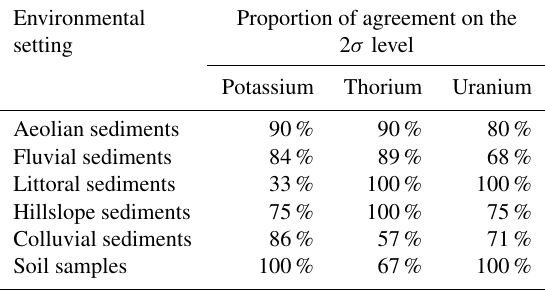
Table 10. Proportions of agreement on the 2 σ level between µ Dose results and results obtained by different techniques of determining radionuclide concentrations and/or activities (TSAC/ICP-OES and low-level HRGS). Results are grouped according to different sedi- mentary